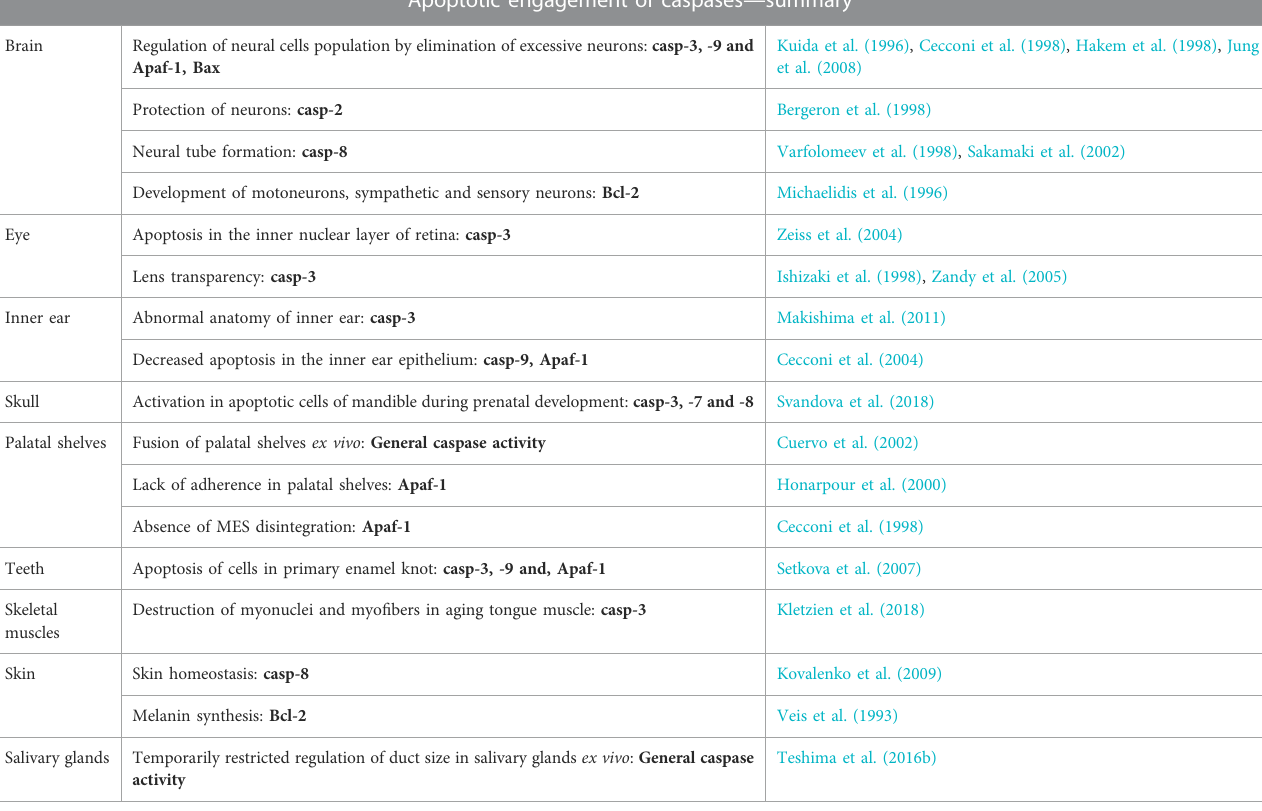
TABLE 2 Overview of caspase apoptotic functions during development of